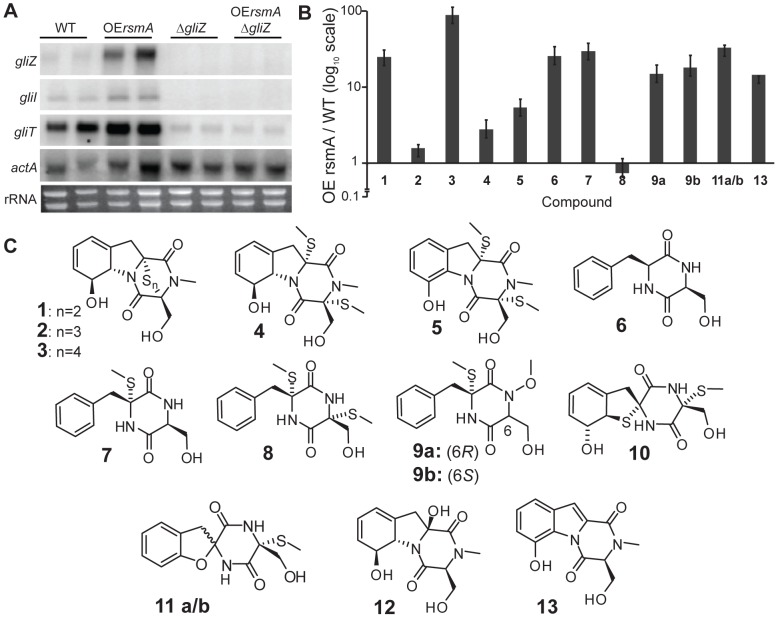
RsmA regulates production of gliotoxin and is dependent on gliZ.
A.
gliZ, gliI and gliT gene expression in liquid shaking cultures. gliZ, gliI and gliT expression in A. fumigatus (AF293) wild type, OErsmA, ΔgliZ, and OErsmAΔgliZ. All strains were grown in 50 mL GMM liquid shaking culture at 25°C and 280 rpm for 72 h. Total RNA was extracted from mycelia and probed for gliZ, gliI and gliT. WT = wild type. B. Relative amounts of compounds 1–13 in OErsmA compared to WT. Compounds 10 and 12 were not detected in the OErsmA nor WT cultures. Compounds 11a/b and 13 were not detected in wild type, their values represent the measured S/N ratio as determined by their diagnostic mass ion chromatograms. Data was triplicated and the error bars represent 1 standard deviation. C. Collection of gliZ-dependent metabolites profiled in this study, structures and gliZ-dependency in A. fumigatus was previously established in [38].